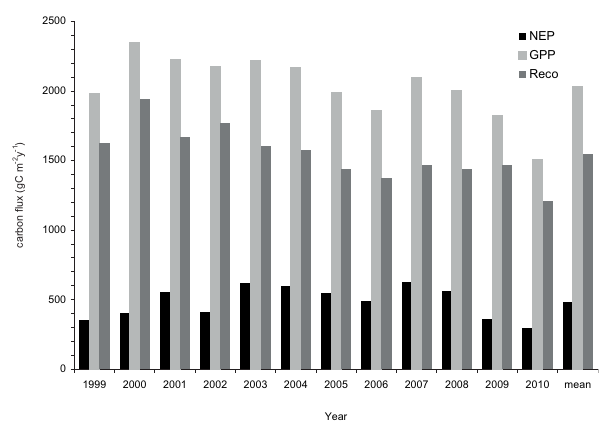
Fig. 5. Annual sum of NEP, GPP and R eco for the period